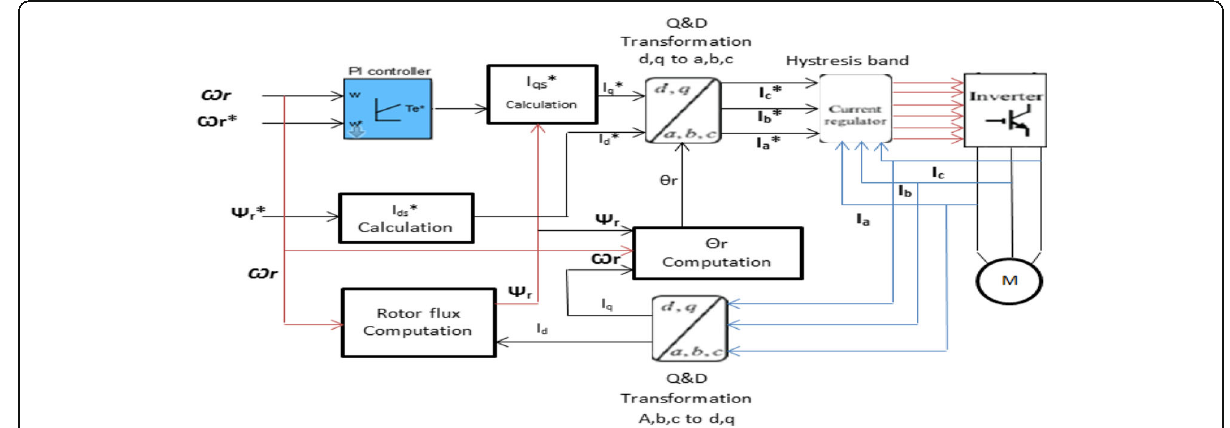
Fig. 4 Indirect vector control detailed block